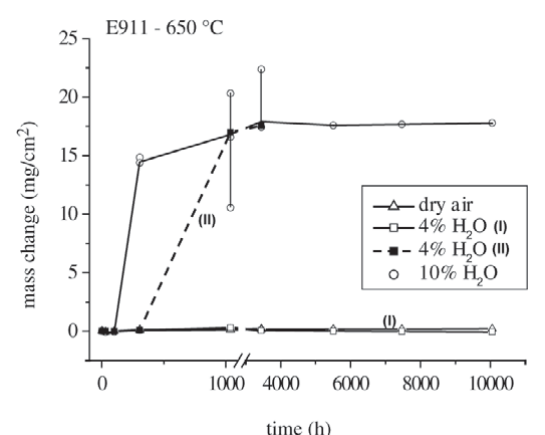
Figure 5. Results of mass change measurement as a function of time for steel E911 at 650 °C in different environments.